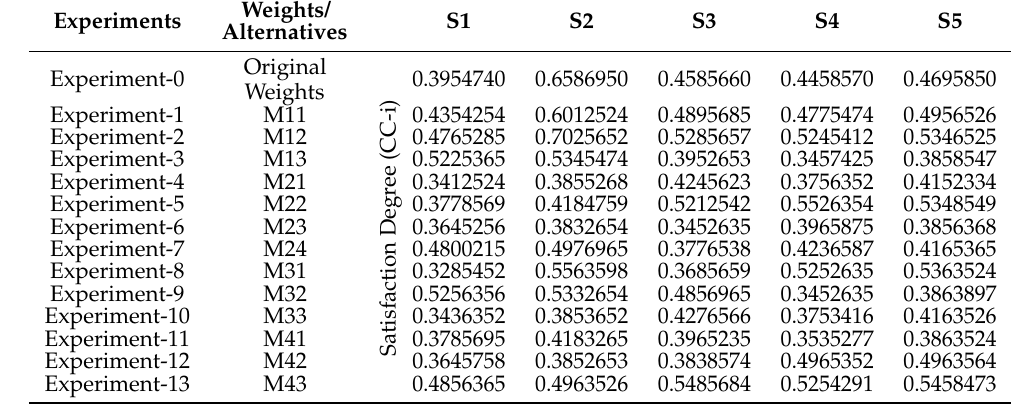
Table 20. Sensitivity analysis.